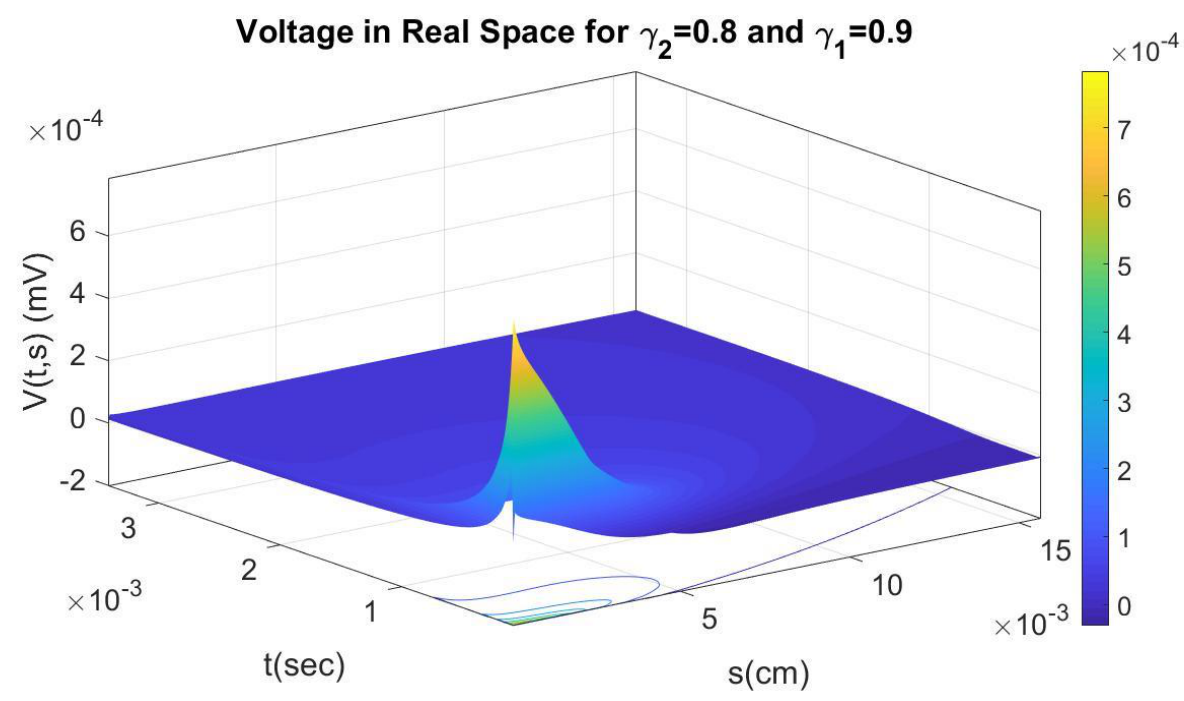
Figure 5. The voltage V Λ (T,S) in Λ -space as a function of time T and arc length S.